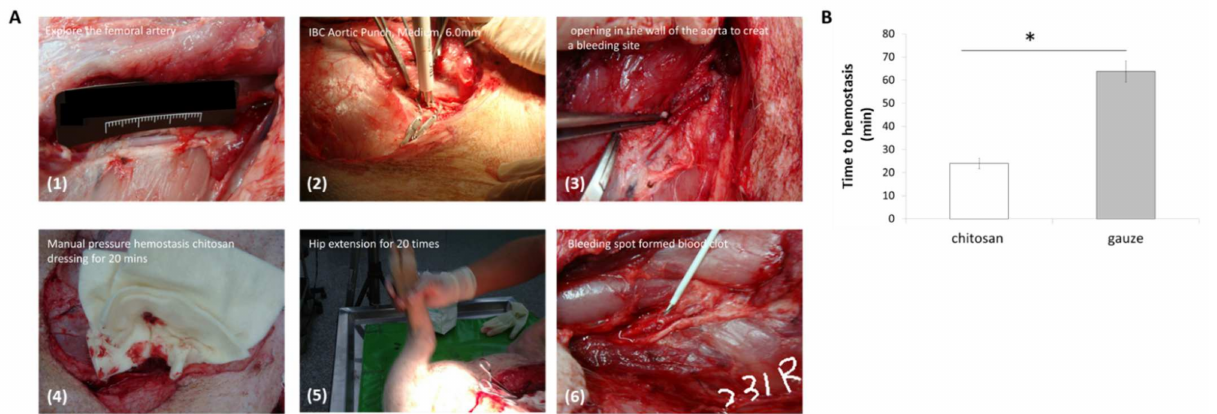
Figure 2. The femoral artery hemorrhage swine model. ( A ) The process of femoral artery hemorrhage creation (the number on the figure shows the order of surgery process); ( B ) Time to hemostasis comparison between chitosan dressing and gauze (* p <